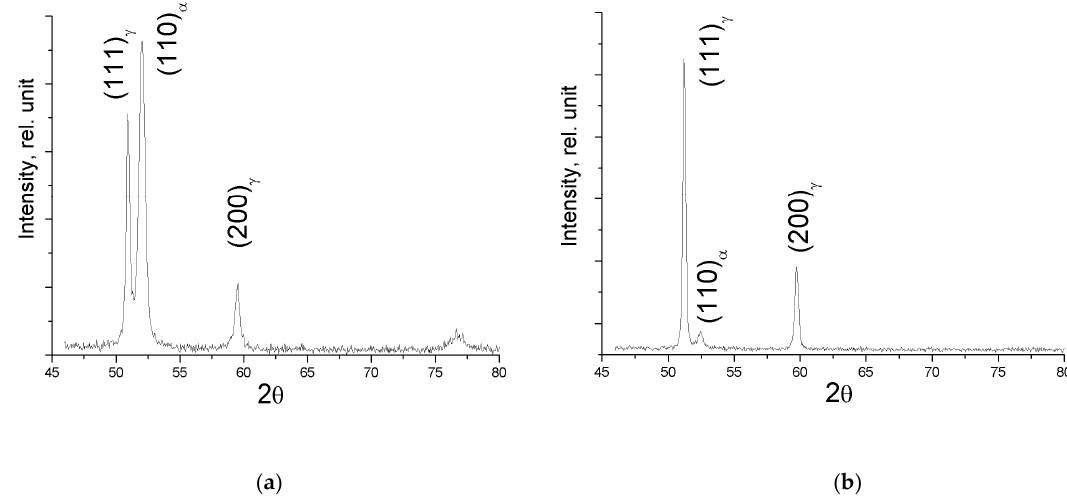
Figure 1. X-ray di ff raction patterns of TRIP steel in state 2 : ( a ) on the surface after austenitization; Figure 1. X-ray diffraction patterns of TRIP steel in state 2 : ( а ) on the surface after austenitization; ( b ) ( b ) after removal of a 20 µ m thick surface after removal of a 20 μ m thick surface layer.